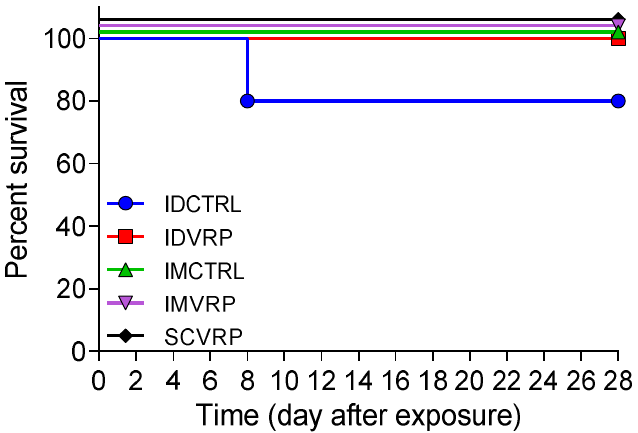
Figure 3. NHP percent survival after exposure to WEEV CBA87. One of five ID-control NHPs met euthanasia criteria on day 8 post exposure to WEEV CBA87 (80% survival rate). NHPs were euthanized when a clinical score of 12 (or greater was observed or at end of study. All other control and all WEVEE VRP-vaccinated NHPs survived to study end-point.